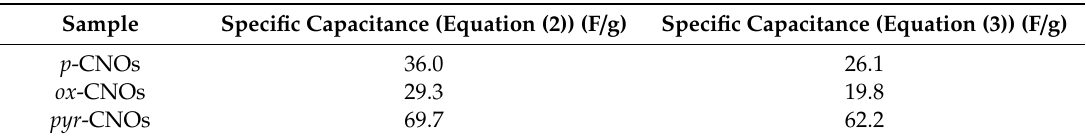
Table 2. The specific capacitance of the functionalized and non-functionalized CNOs based on the CV